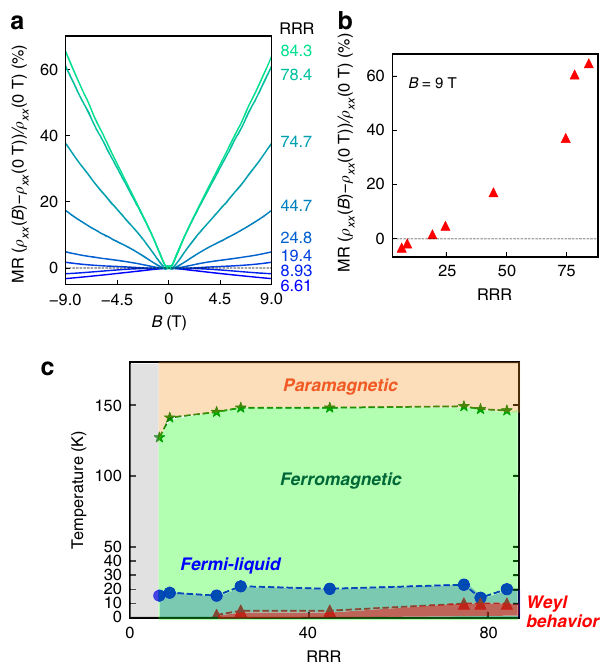
Fig. 4 RRR dependence of the transport phenomena in SrRuO 3 . a RRR dependence of the MR ( ρ xx ( B ) − ρ xx (0 T))/ ρ xx (0 T) measured at 2 or 2.3 K. When RRR > 19.4, the positive MR, which is one piece of experimental evidence of the Weyl fermions in SrRuO 3 , clearly emerges. b RRR dependence of the MR ( ρ xx ( B ) − ρ xx (0 T))/ ρ xx (0 T) at B = 9 T and T = 2 or 2.3 K. c Diagram of the RRR dependence of T C , T F , and T W , which are shown as green stars, blue circles, and red triangles,